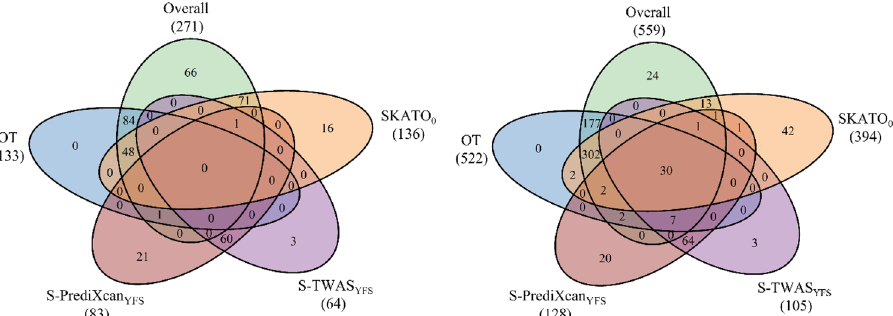
Figure 3. Venn diagram of the number of genes identified by Overall, OT, and SKATO 0 , S-PrediXcan YFS , and S-TWAS YFS for SCZ1 data (left) and SCZ2 data (right). The number below each method indicates the total number of significant genes identified by the corresponding